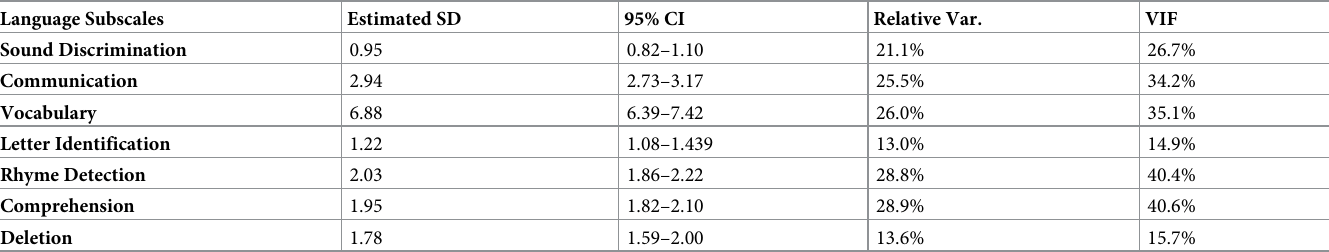
Table 4. Estimated SD, relative variance, and VIF assigned to educators for a misspecified model with only two levels.